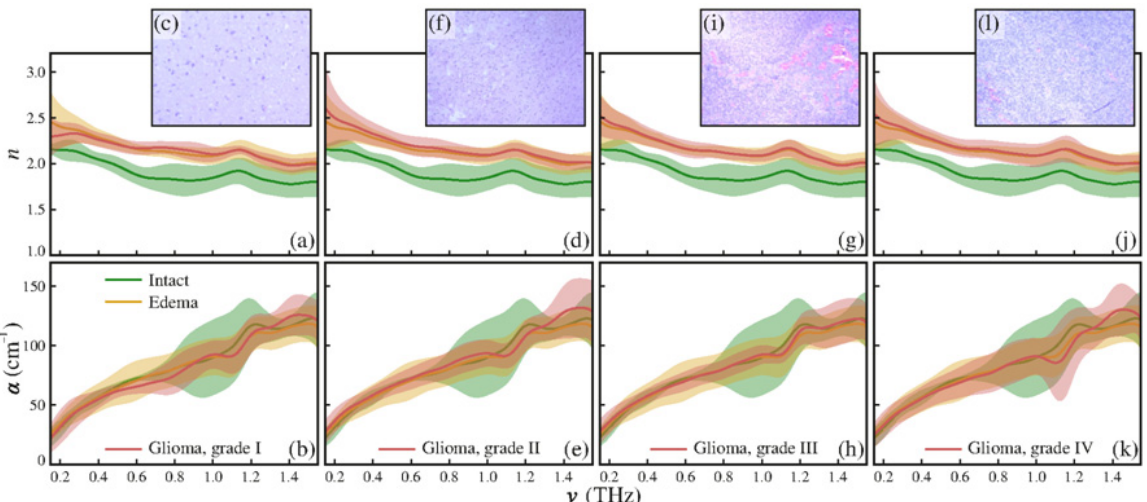
Figure 7. Refractive index n, absorption coefficient α , and H&E-stained histology of gelatin-embedded human brain gliomas of different World Health Organization (WHO) grades ex-vivo: ( a – c ) Grade I; ( d – f ) grade II; ( g – i ) grade III; and ( j – l ) grade IV. Reprinted from [155].